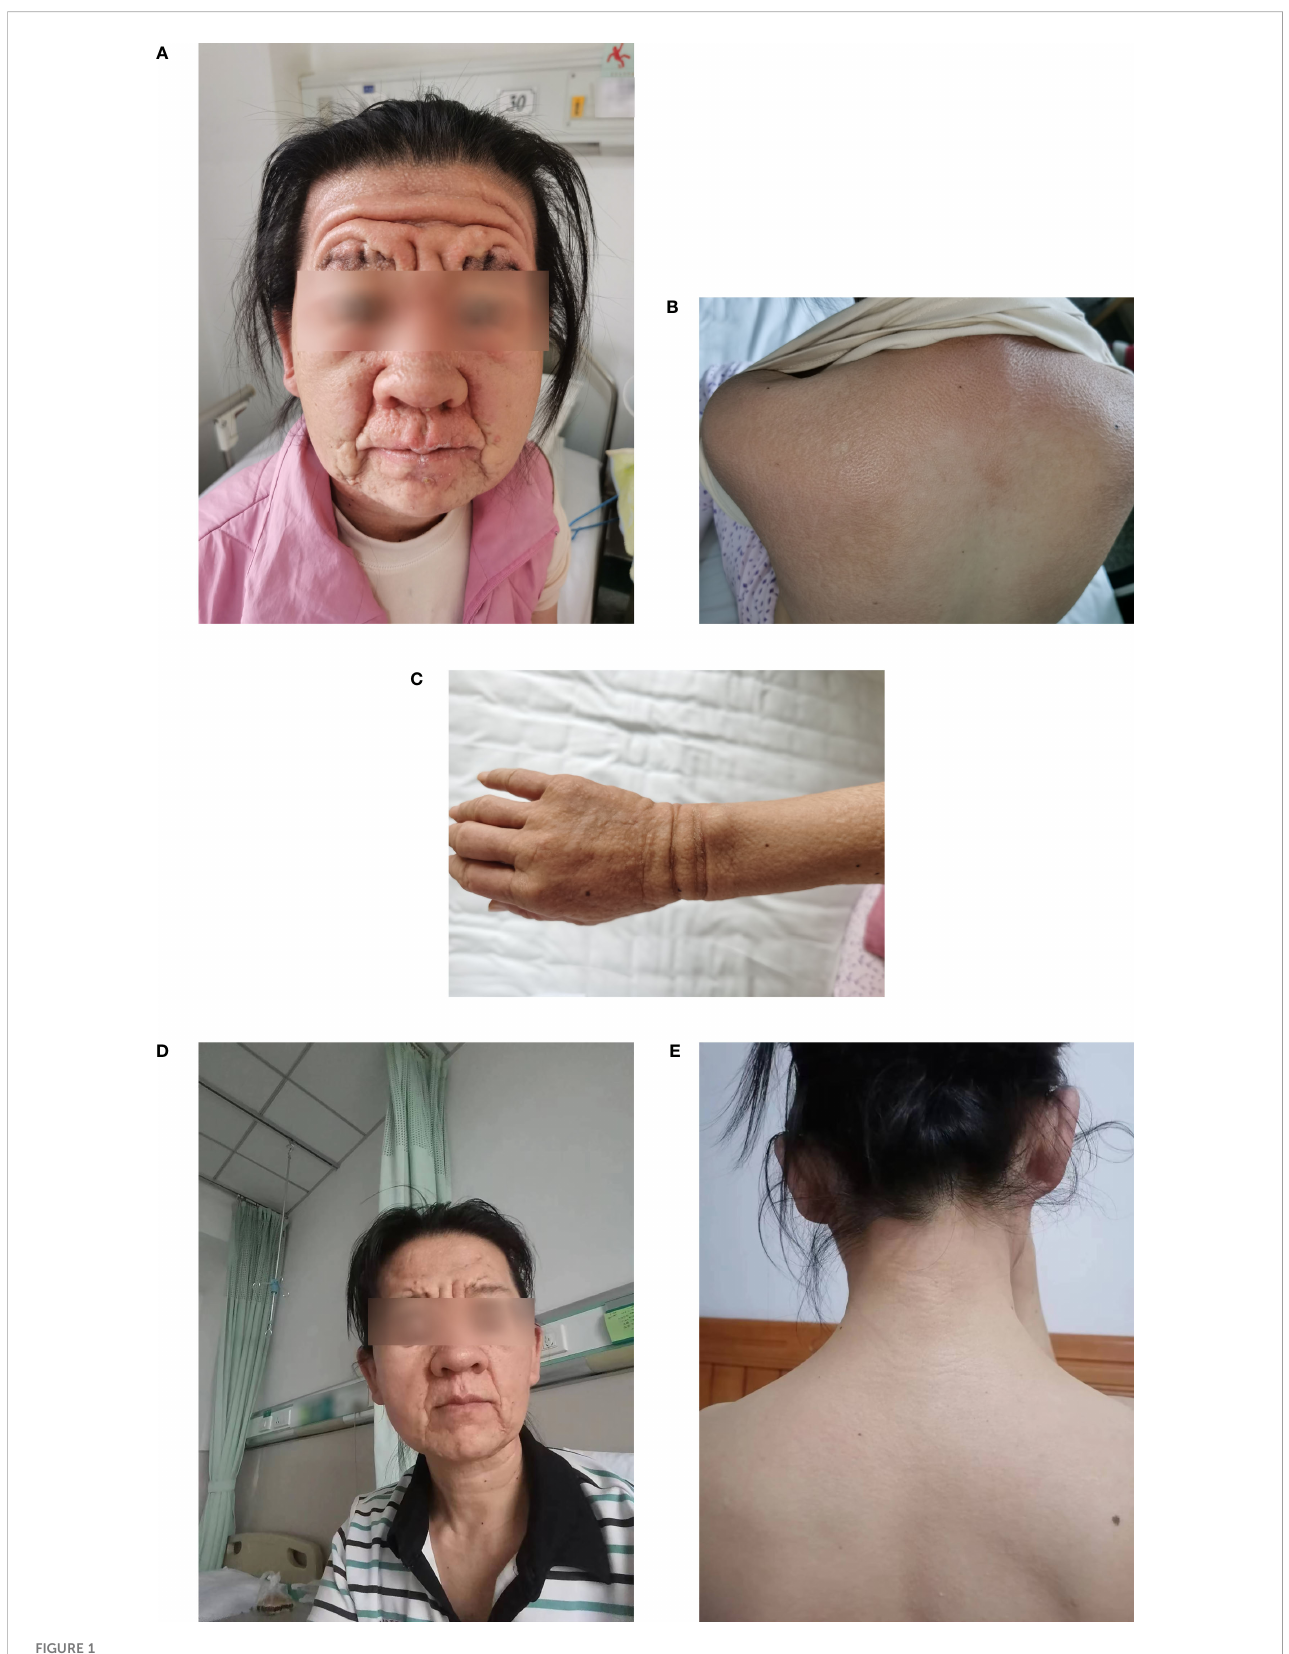
FIGURE 1 (A – C) Cutaneous manifestations before IVIG treatment; (D, E) after six courses of IVIG treatment. IVIG, high-dose intravenous